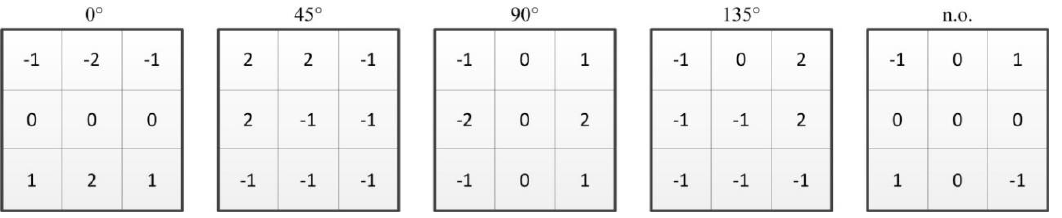
◦ , 45 ◦ , 90 ◦ , and 135 ◦ and no